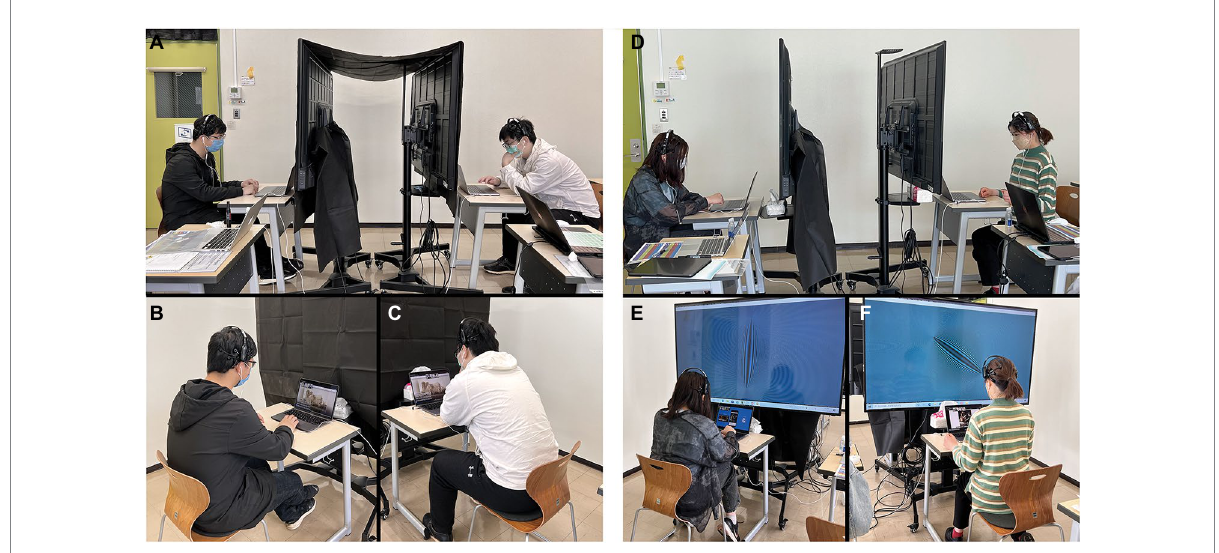
FIGURE 4 (A) The normal online exhibition experience (NOEE) group’s overall experimental scene; (B) The experimental scene of a participant in the NOEE group; (C) The experimental scene of another participant in the NOEE group; (D) The EEG signal visualization device (ESVD) group’s overall experimental scene; (E) The experimental scene of a participant in the ESVD group; and (F) The experimental scene of another participant in the ESVD